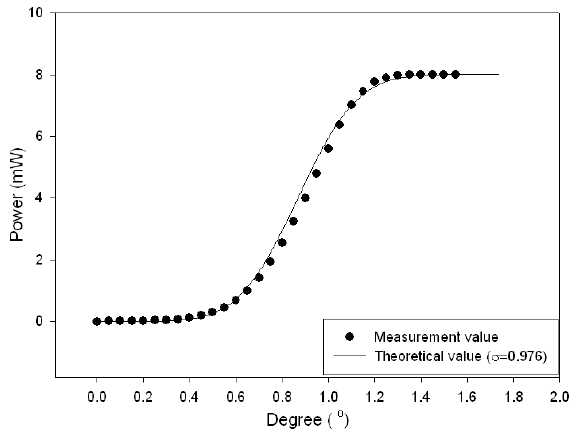
Figure 6. Intensity versus angle variation (Power (mW) – Δθ (°)).